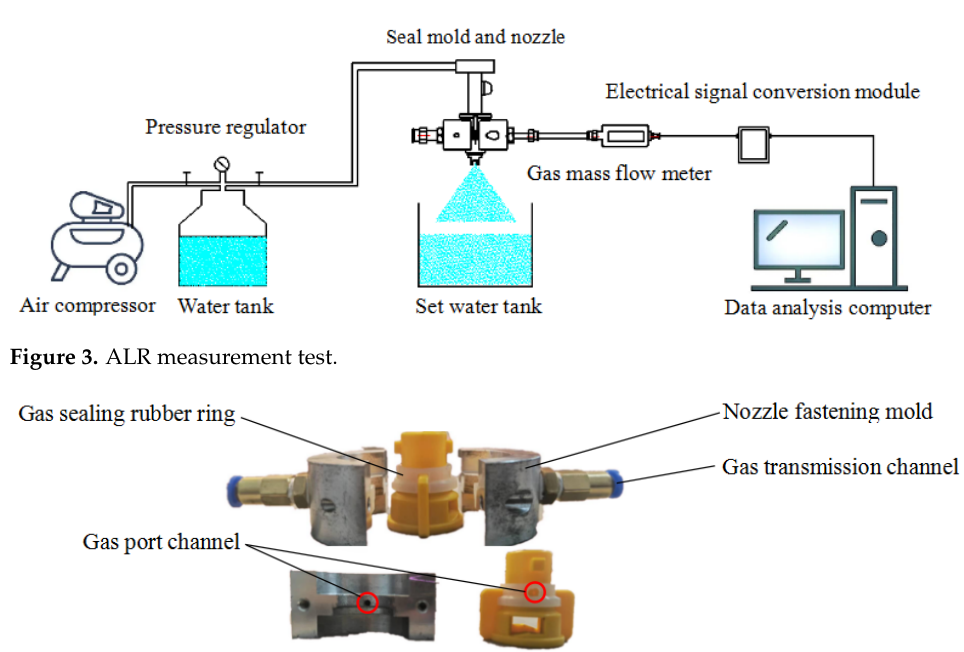
Figure 4. Venturi tube and gas transmission fastening mold installation.